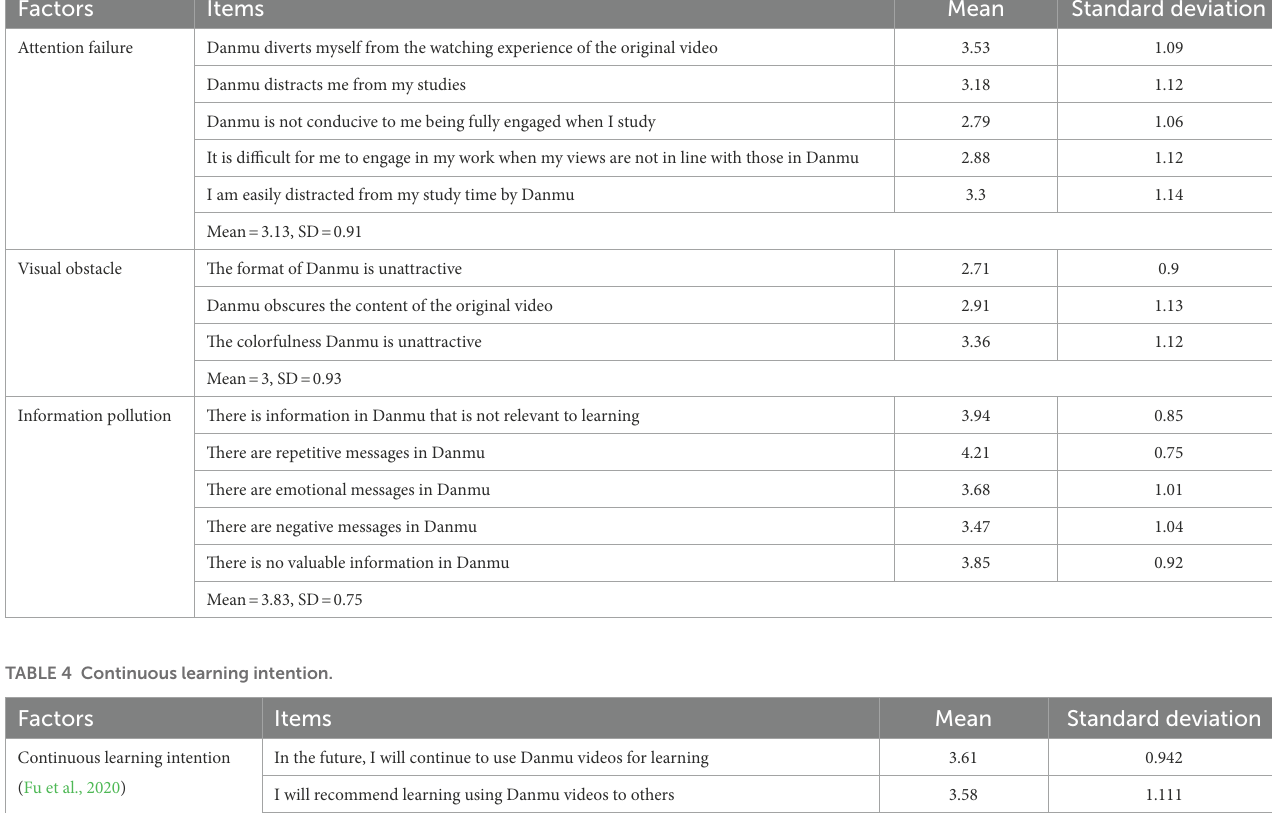
TABLE 3 Hindrance factors in learning with Danmu videos. Factors Items